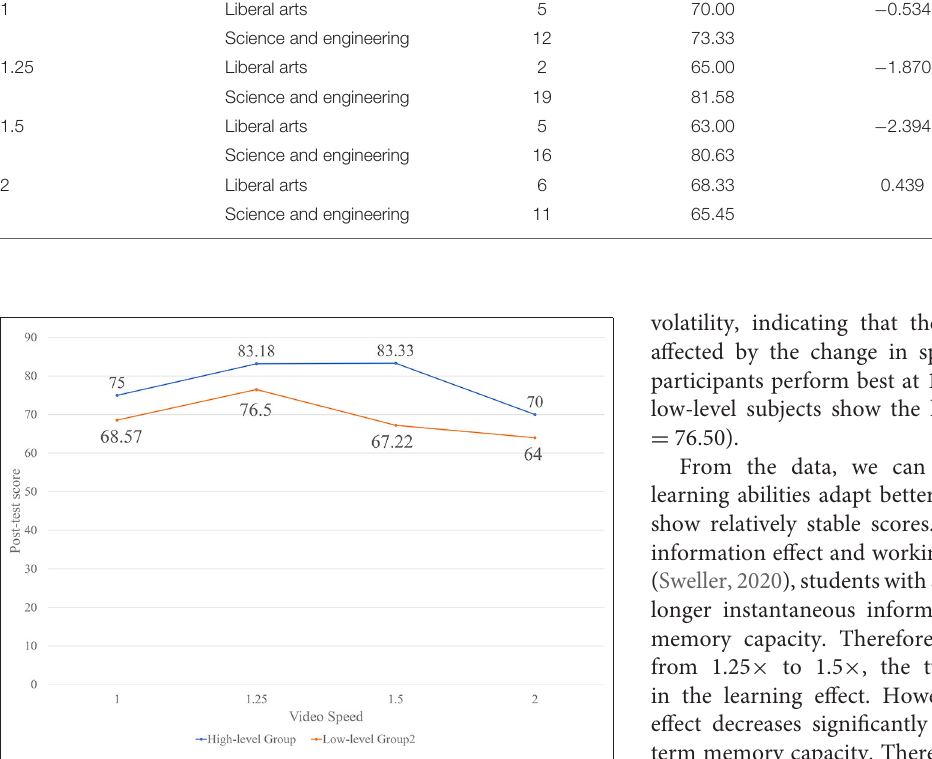
FIGURE 1 | Post-test mean scores of different learning abilities.